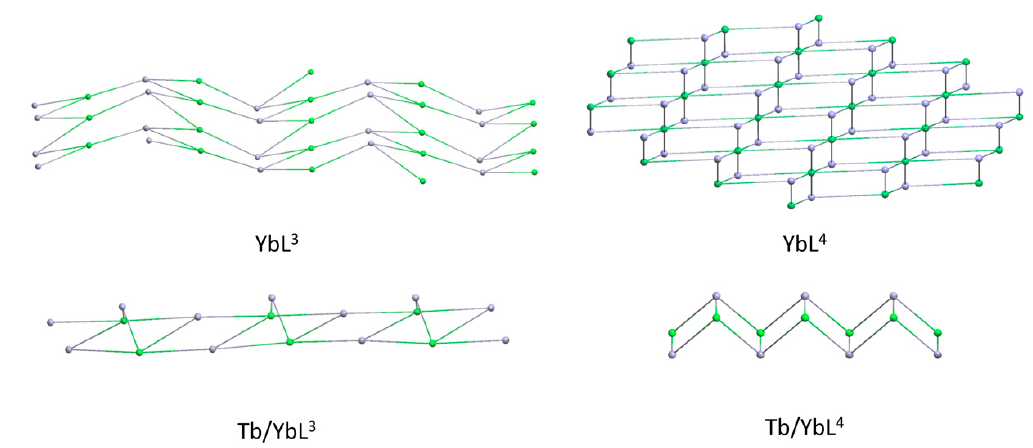
Figure 5. Underlying nets found in the MOFs considering as nodes the metal centers (green spheres) and the ligands (grey spheres).